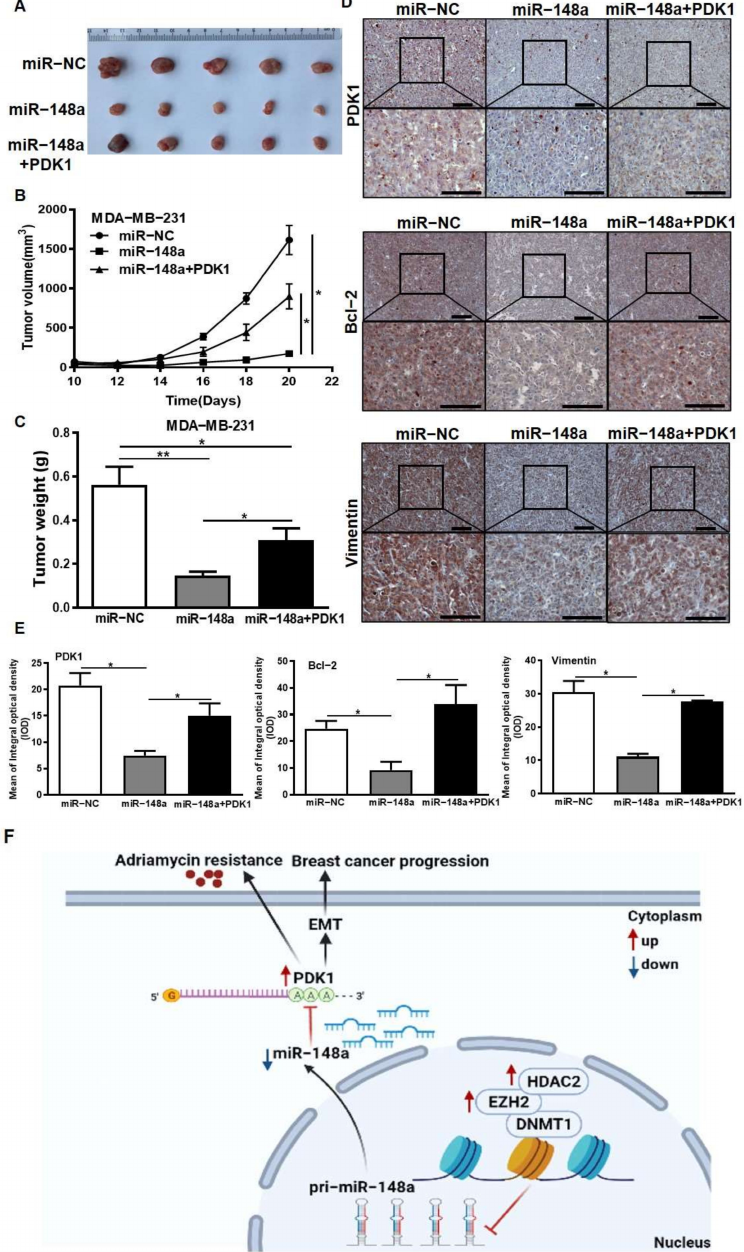
Figure 8. PDK1 partially restores the inhibitory effect of miR-148a on tumor growth. ( A ) MDA-MB-231 carrying miR-NC, miR-148a, and miR-148a + PDK1 stable cells (5 × 10 6 cells) were